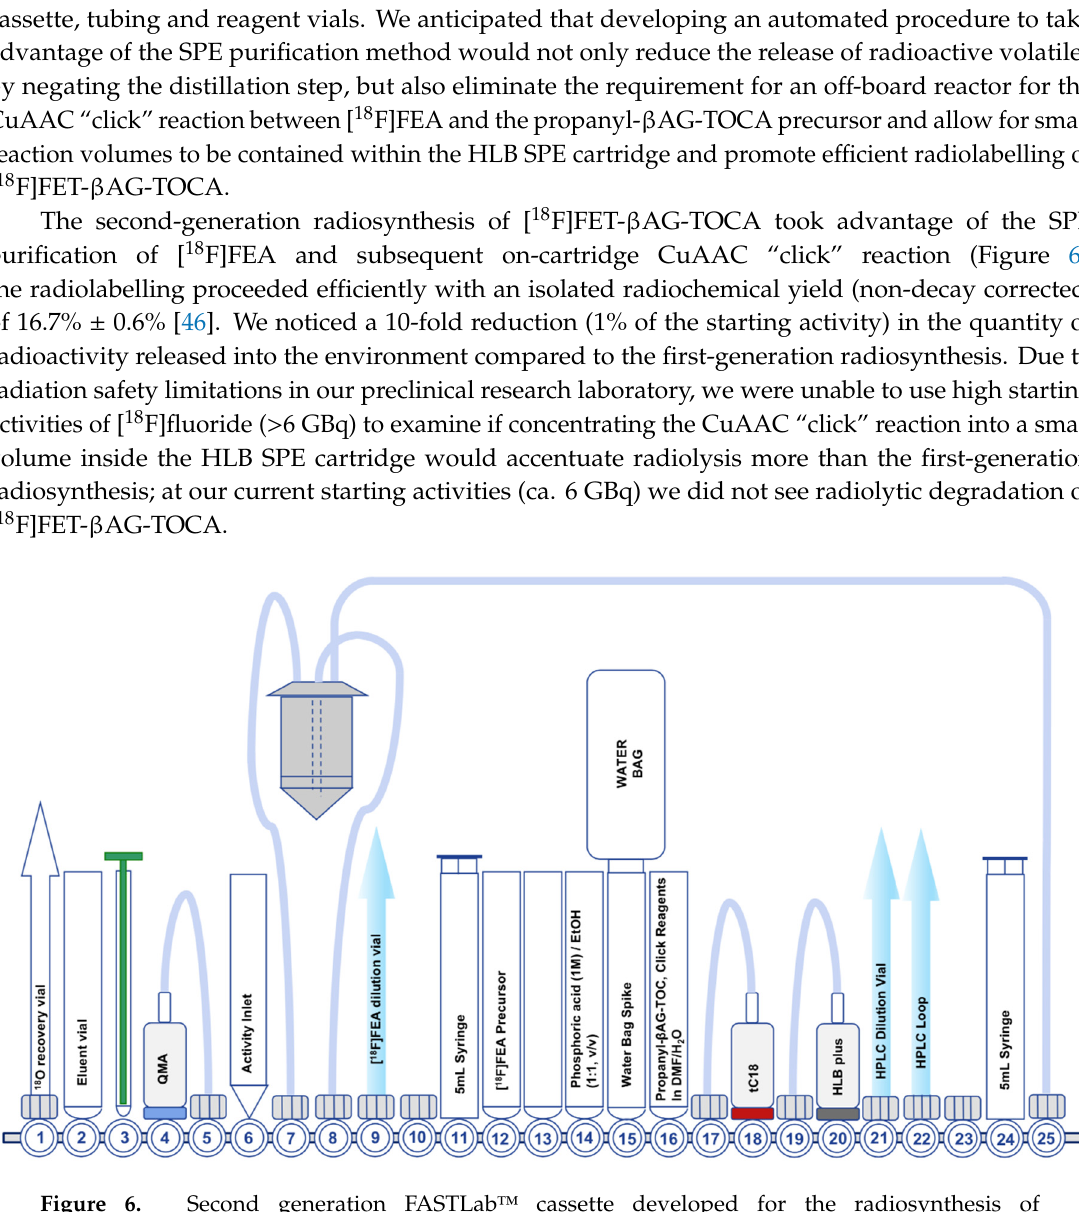
Figure 6. Second generation FASTLab™ cassette developed for the radiosynthesis of [ 18 F]FET- β AG-